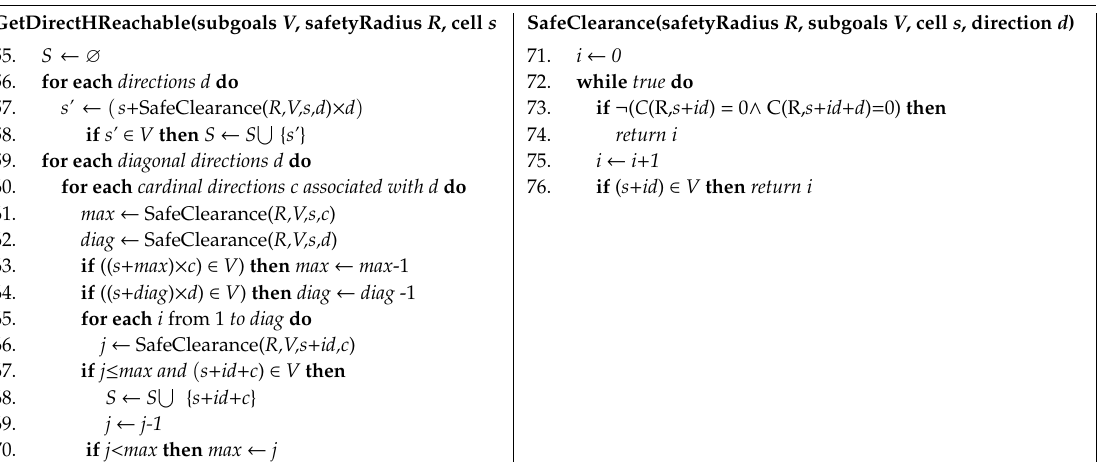
Table 4. The pseudocode of determining the direct-h-reachable area of a given unblocked cell s.